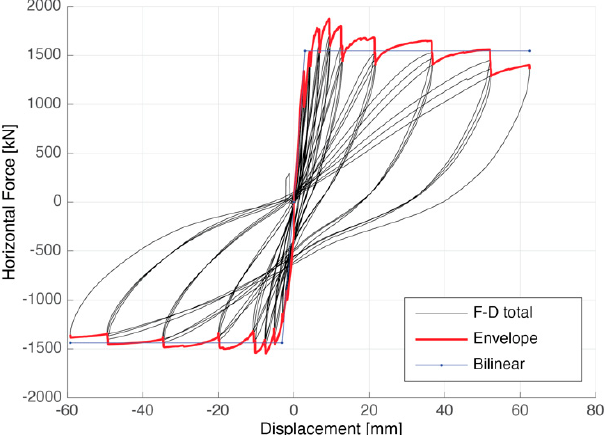
Figure 22. Force-displacement loop of individual actuators. Force is in the test direction, displacement is parallel ( a ) and orthogonal to the test direction ( b ). Buildings 2020 , 10 , x FOR PEER REVIEW